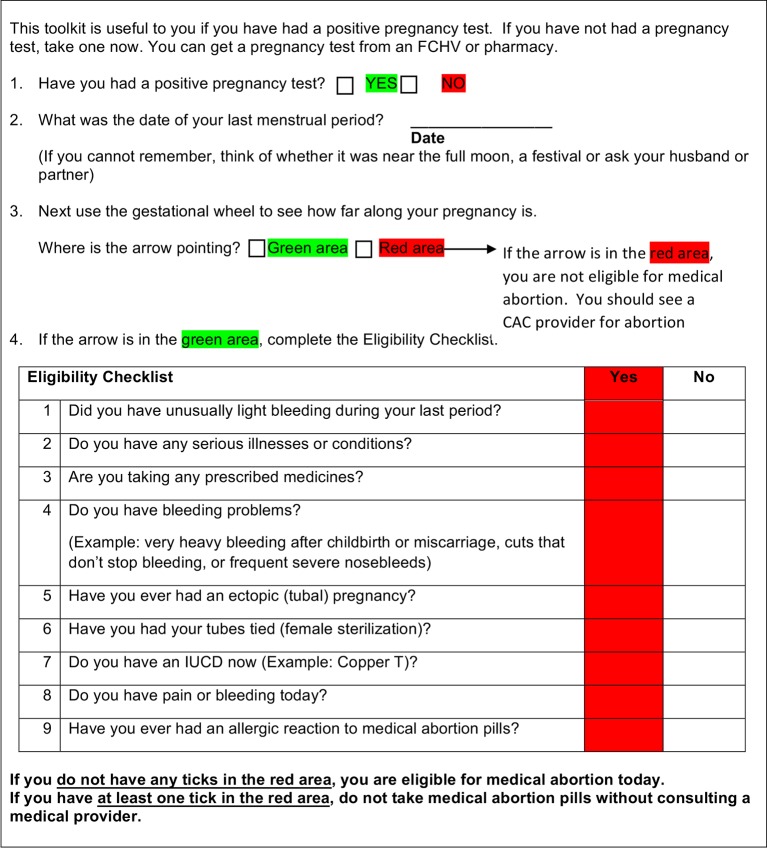
MA eligibility checklist.The user answers the questions in order. The first portion of this worksheet is intended to be used with the gestational dating wheel (see Fig 1). The second portion is the eligibility checklist. A response in a red area for any question indicates that the woman requires further evaluation prior to MA.